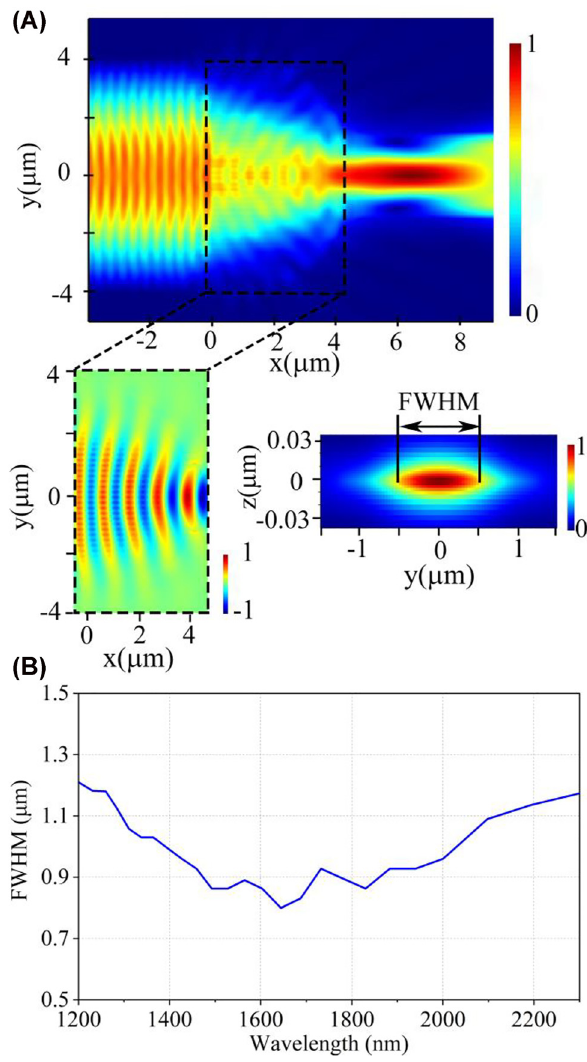
Figure 3: Simulated beam focusing behavior of the on-chip half Maxwell’s fisheye lens. (A) Electrical field distribution of the xy -plane view in the lens. Inset: Enlarged electrical field distribution ) of the dashed box and the cross-section ( yz -plane) of the mode ( E y profile at the interface between the circumference and the output waveguide. (B) FWHM values of the output mode.